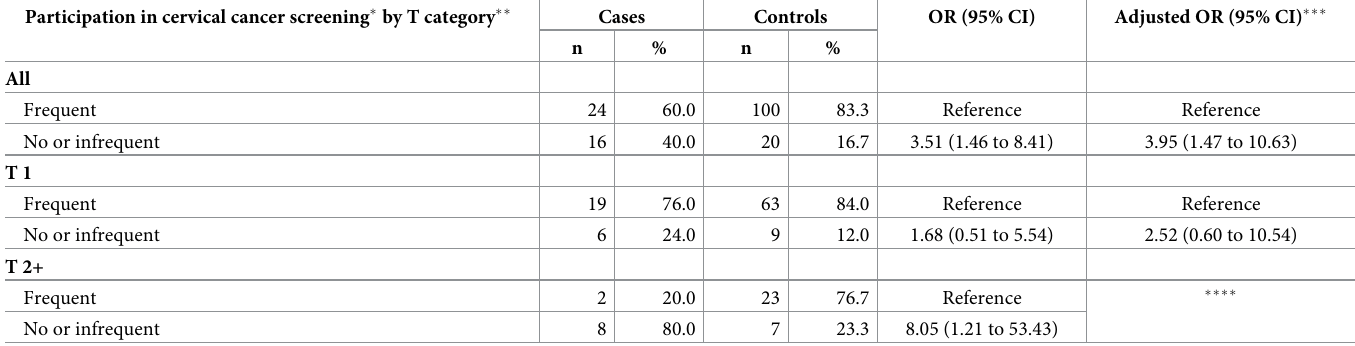
Table 5. Participation in cervical cancer screening during the past ten years among cases and controls, according to T category, adenocarcinoma/adenosquamous carcinoma (40 cases and 120 controls). Participation in cervical cancer screening � by T category